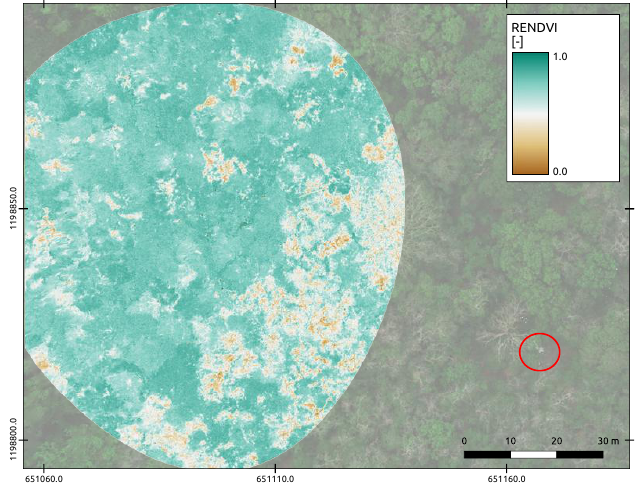
Figure 4. Generated VIS-NIR orthomosaic as an overview of the tower area including the footprint of the EC system in RGB representation. Red circle indicates the position of the EC system.